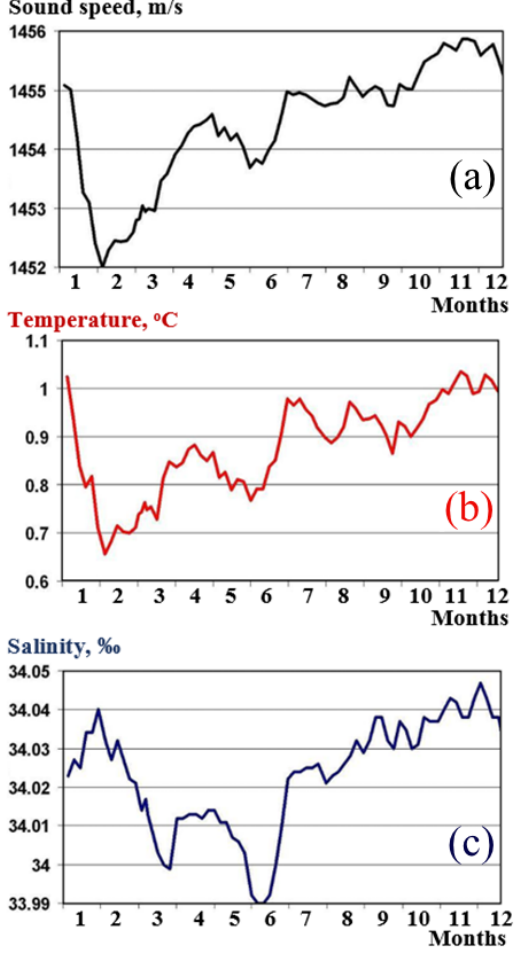
Figure 14. Seasonal changes in the average weighted values of sound speed ( a ), temperature ( b ), and water salinity ( c ) in the USC on the shelf route near Cape Schultz–Kita-Yamato Bank. The horizontal axis is months.